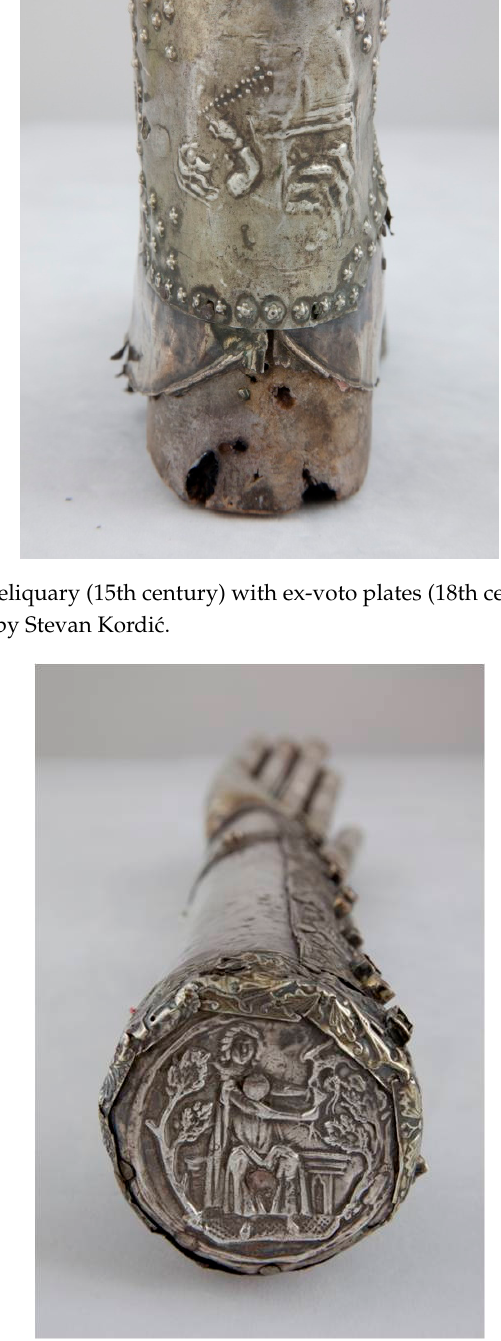
Figure 13. Bottom of an arm-shaped reliquary, 14th century, Cathedral of Saint Tryphon, Kotor.